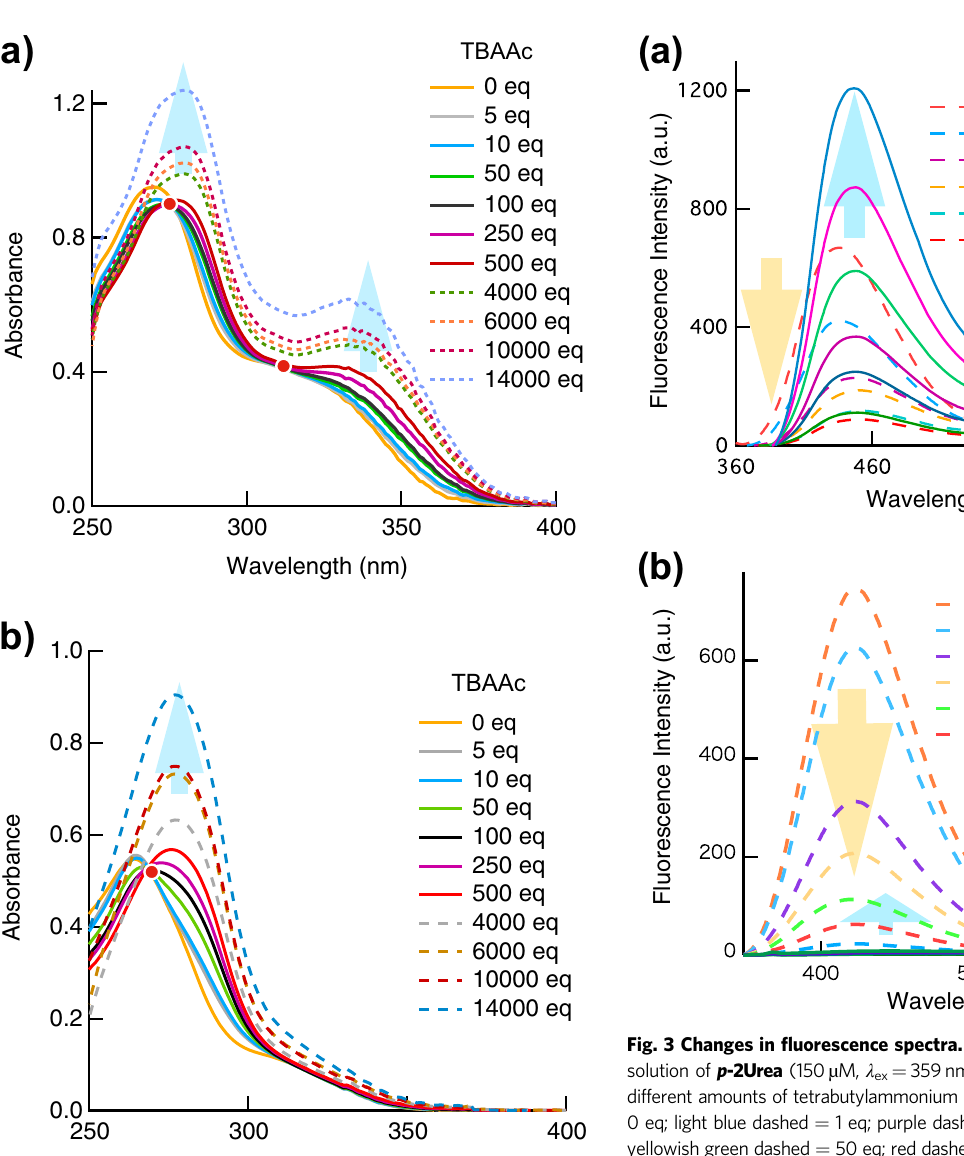
Fig. 2 Changes in UV-visible absorption spectra. Absorbance spectra of a p -2Urea and b m -2Urea in the absence and presence of different amounts of tetrabutylammonium acetate (TBAAc) (orange = 0 eq; grey = 5 eq; light blue = 10 eq; yellowish green = 50 eq; green = 100 eq; purple = 250 eq; red = 500 eq; grey dashed = 4000 eq; brown dashed = 6000 eq; reddish brown dashed = 10,000 eq; light blue dashed = 14000 eq).